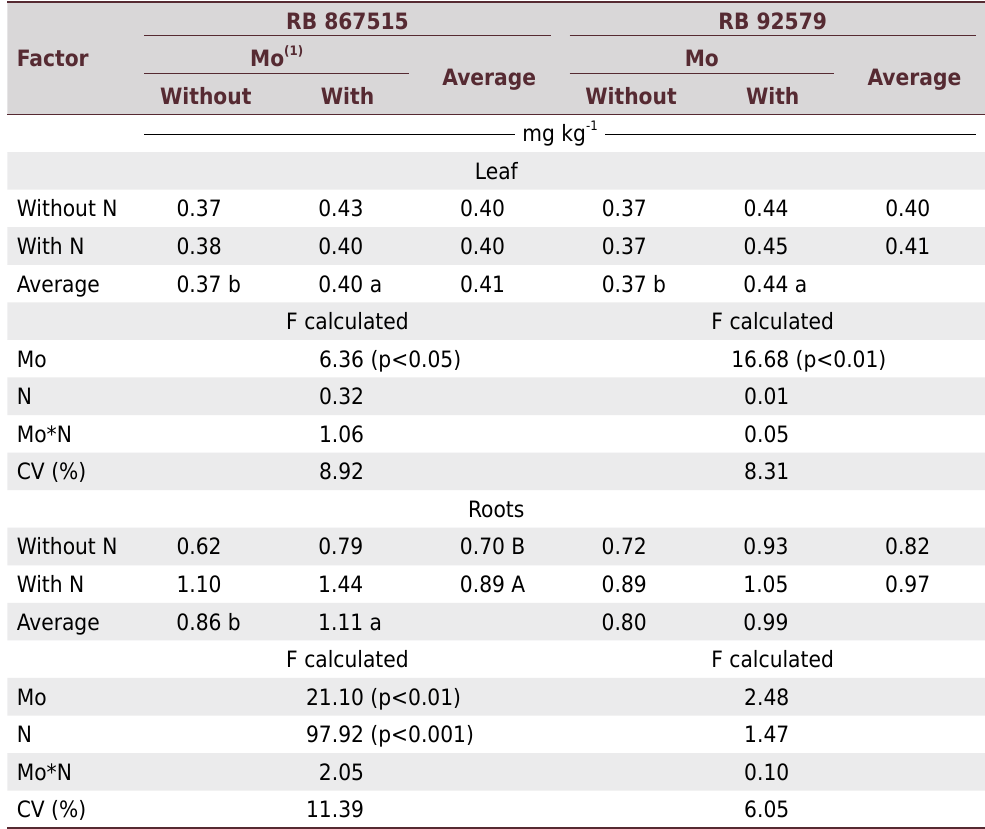
Table 2. Molybdenum content in the leaves and roots of the sugarcane varieties RB 867515 and RB 92579, with and without Mo and N